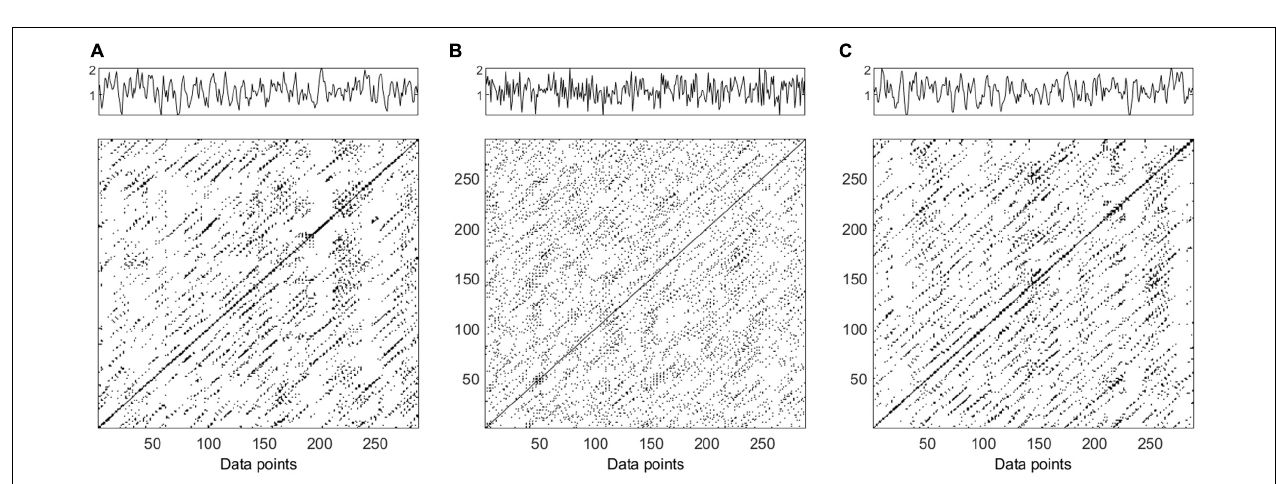
FIGURE 1 | Full-size panels depict synthetic time series, original (left column), one Iterative Amplitude Adjusted Fourier Transform (IAAFT) surrogate time series (middle column) and one Pinned Wavelet Iterative Amplitude Adjusted Fourier Transform (PWIAAFT) ( ρ = 0.01) surrogate time series (right column). AR2s Eq. (1) time series corresponds to top row, while the AR2ns one Eq. (2) is in the bottom row. (A) original AR2s, (B) IAAFT surrogate and (C) PWIAAFT ( ρ = 0.01) surrogate. (D) AR2ns Eq. (2) and one example of (E) IAAFT surrogate and (F) PWIAAFT ( ρ = 0.01) surrogate. Small-size panels show 8 randomly selected segments of 50 data points obtained from the whole time series. The dashed lines represent the means and the dotted lines indicate one standard deviation. AR2s original, IAAFT and PWIAAFT surrogate series were identified as stationary. Whereas AR2ns original and PWIAAFT surrogate series were regarded as nonstationary, the corresponding IAAFT surrogate was identified as stationary. Time series in all panels are shown as arbitrary units.